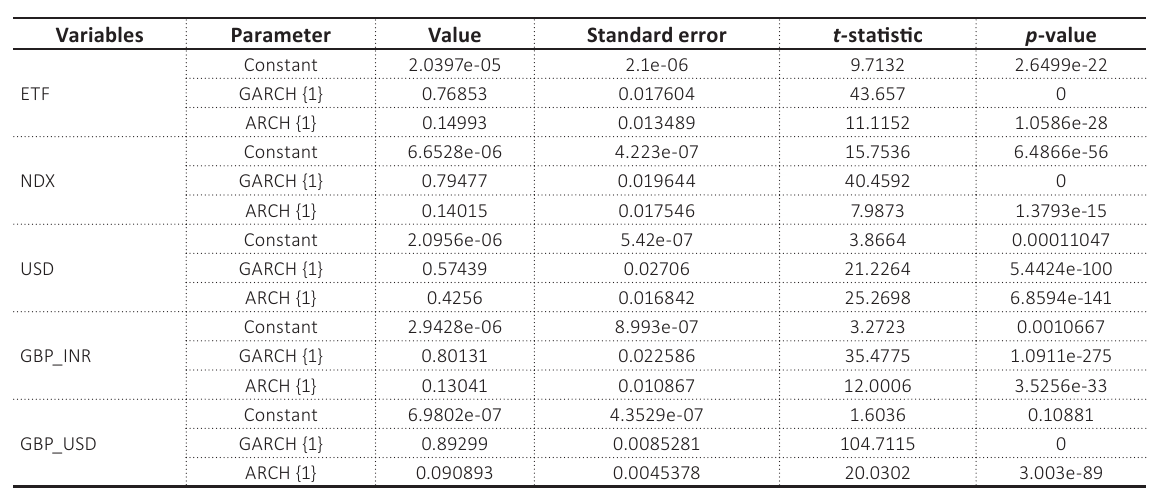
Table 2. Test results of GARCH